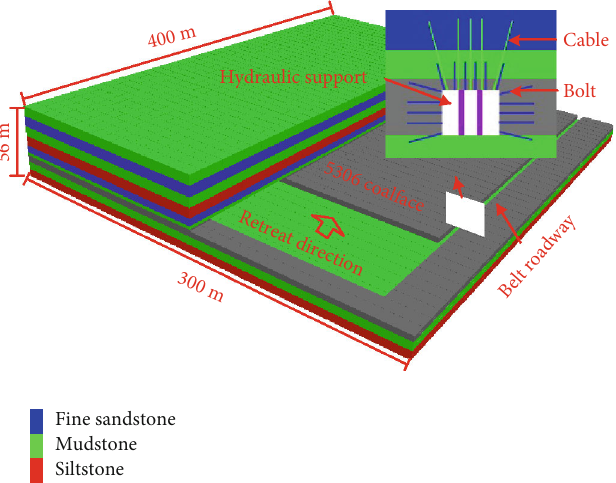
Figure 4: Establishment of the numerical model.